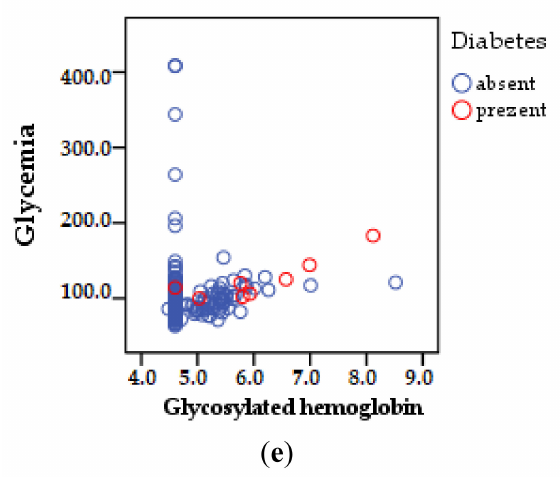
Figure 3. Comparative carbohydrate profile between groups: ( a ) glycemia (mg/dL); ( b ) glycosylated hemoglobin (%); ( c ) Pearson correlation between blood glucose and glycosylated hemoglobin; ( d ) Pearson correlation regarding the prevalence of diabetes; ( e ) Pearson correlation pre-existing diabetes, blood sugar, and glycosylated hemoglobin (comparative histogram and dot cloud,